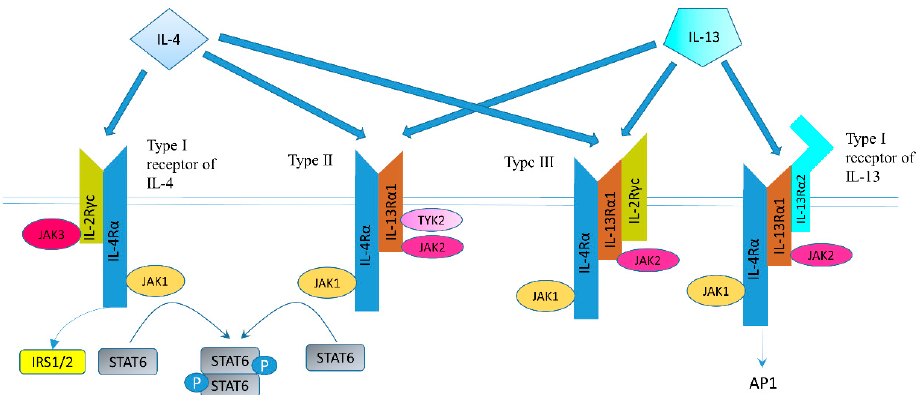
Figure 1. Receptor types and signal transduction of IL-4R and IL-13R. There are three different kinds of IL-4 receptors. IL-4 binds to the IL-4R α chain, then recruits the IL-2R γ -common ( γ c) chain (type I IL-4R) or the IL-13R α 1 chain (type II IL-4R) to form a receptor complex that can initiate signal transduction. The type III IL-4R consists of all three chains. IL-13 also have three different receptors. IL-13 receptor type I (IL-4R α /IL-13R α 1/IL-13R α 2) and type II (IL-4R α /IL-13R α 1) are expressed in solid tumors, while type III (IL-4R α /IL-13R α 1/ γ c) is expressed in hemocytes only. IL-13 binds IL-13R α 1 with a low affinity and complexes with the IL-4R α (type II receptor). IL-13 binds to the IL-13R α 2 with a high affinity. IL-13 can bind to a soluble IL-13R α 2 receptor, which has no downstream signaling, or bind to transmembrane IL-13R α 2 and activate AP-1. Figure sketch adapted from reference